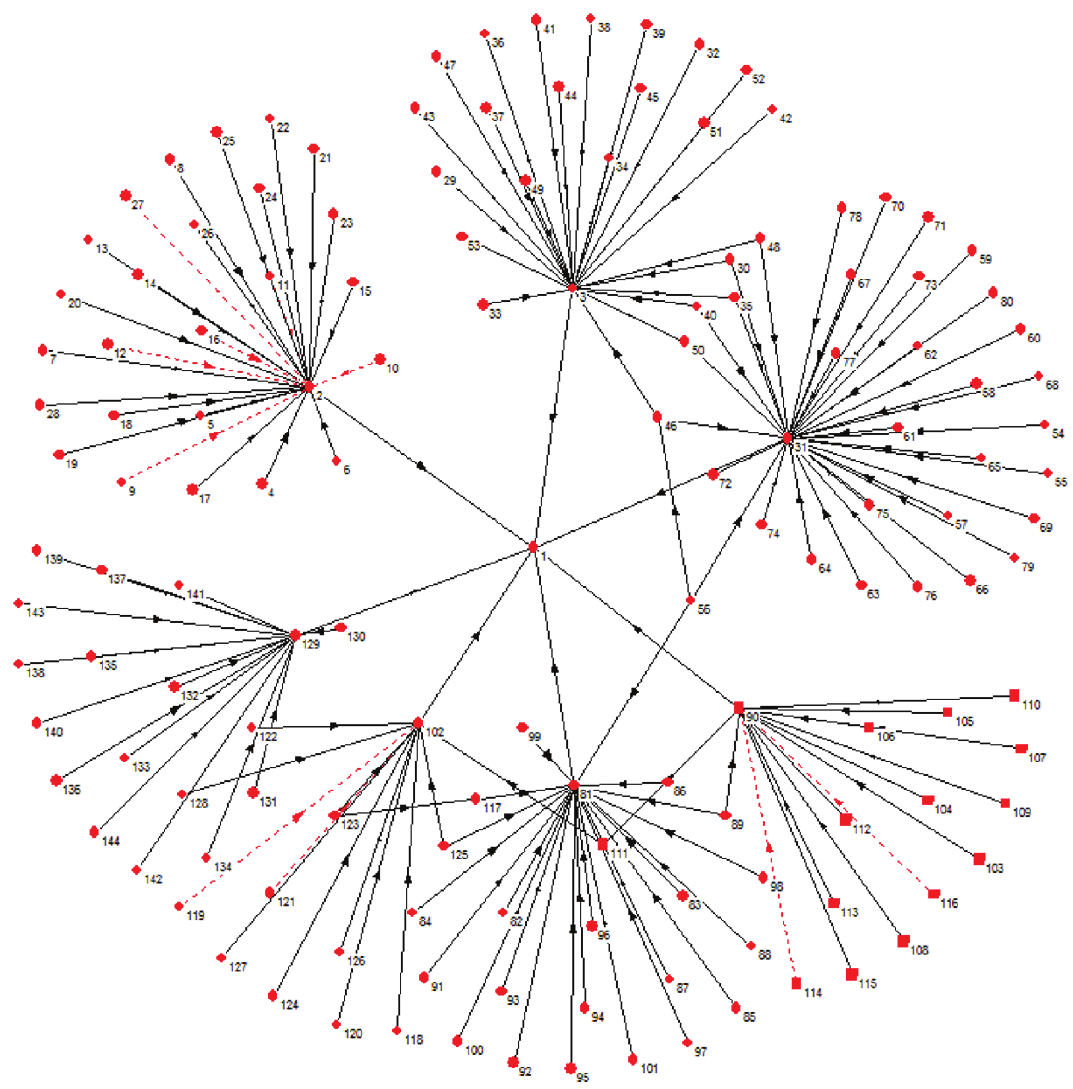
Figure 4. Basic structure of the FCM